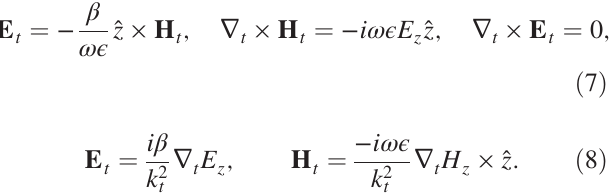
FIG. 4. Regions of analysis for the open-resonator model, shown over the cross section for one period (gap) in the iris- line